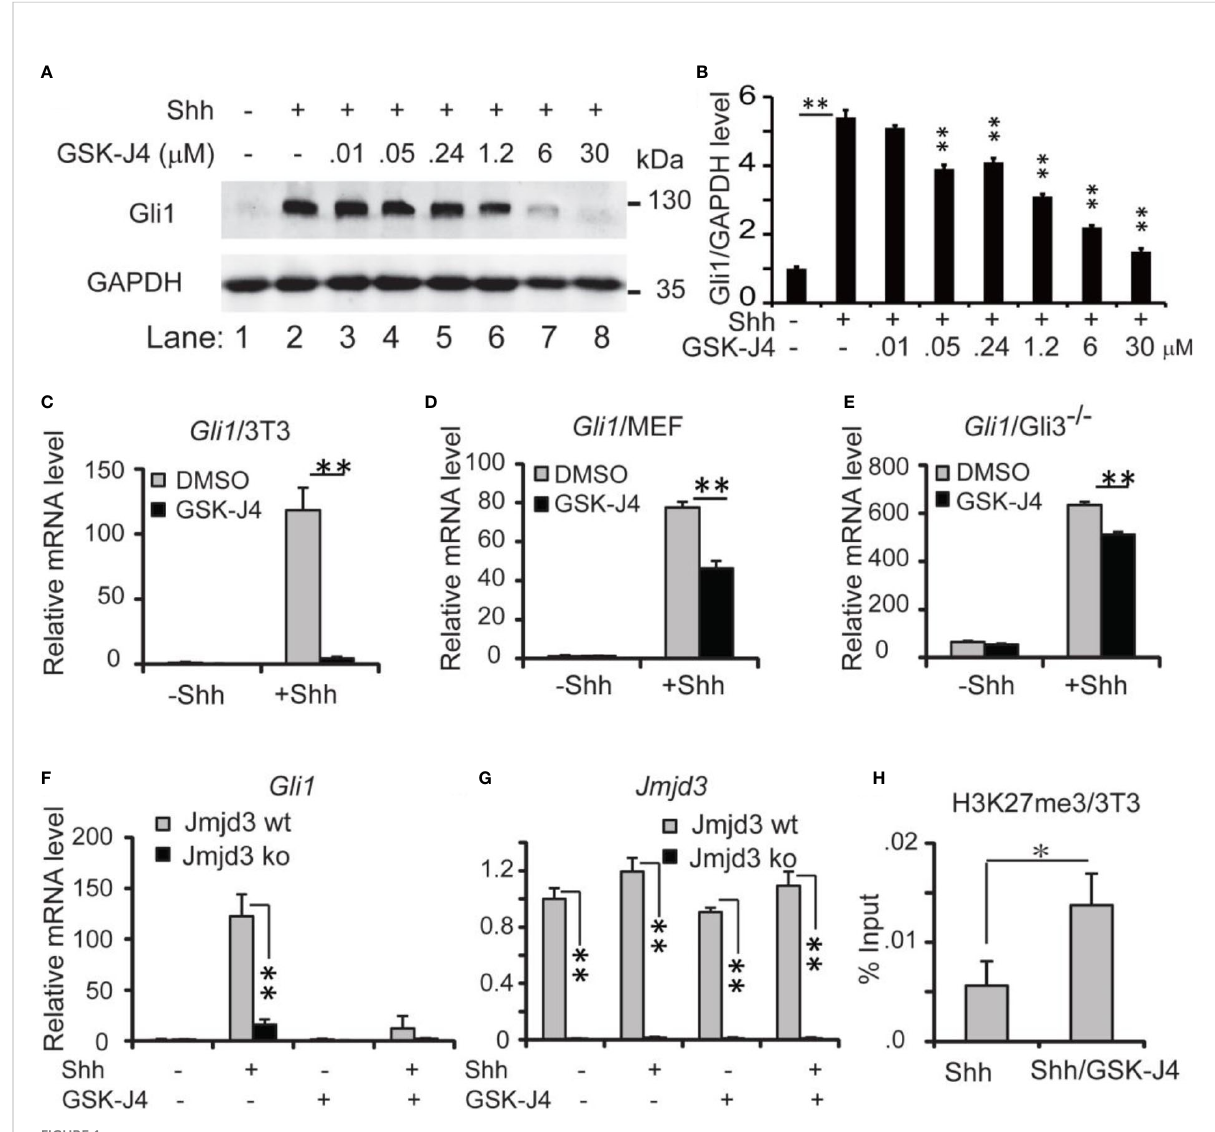
FIGURE 1 Shh signaling is impaired by GSK-J4 targeting H3K27me3 demethylase Jmjd3. (A) Effects of GSK-J4 at various concentrations on Gli1 protein levels. (B) Ratio of Gli1 protein levels against GAPDH in (A) calculated by Image J Signi fi cance is against Shh induced level ( rf Figure 1A, lane 2) except for the one between Figure 1A lane 1 and Figure 1A lane 2. (C) GSK-J4 impairs Shh-induced Gli1 mRNA expression in NIH3T3 cells by RT-qPCR analysis. (D) GSK-J4 inhibits Shh-induced Gli1 mRNA expression in primary MEF cells. (E) GSK-J4 signi fi cantly inhibits Shh-induced Gli1 mRNA expression in primary Gli3 -/- MEF cells. (F) Shh-induced Gli1 mRNA expression is impaired in primary Jmjd3 -/- MEF cells, and GSK-J4 does not further decrease the Gli1 mRNA level. (G) Jmjd3 mRNA expression is reduced by Jmjd3 knockout. (H) GSK-J4 raises the local H3K27me3 enrichment at mouse Gli1 promoter region shown by ChIP q-PCR assay. The concentration of GSK-J4 is 30 m M if not indicated for all fi gures. Signi fi cance determined using Student ’ s t -test. ** p < 0.01 and * p <